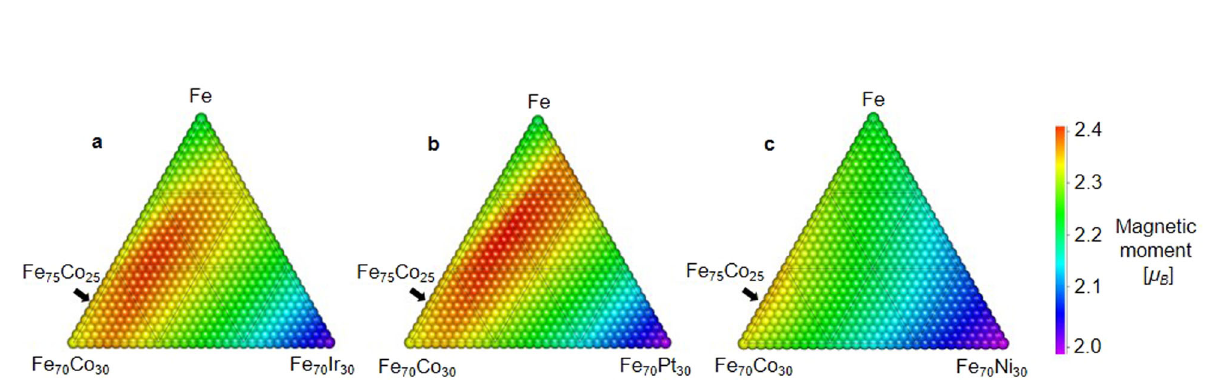
Fig. 3 Experimental con fi rmation by combinatorial XRD, MOKE, and SQUID experiments. a Illustration of combinatorial sputtering system with an automated moving mask for synthesizing Fe x Co y Ir 100-x-y , Fe x Co y Pt 100-x-y , and Fe x Co y Ni 100-x-y composition-spread thin fi lms on SiO 2 /Si substrates. b Composition map of Fe x Co y Ir 100-x-y composition-spread thin fi lm, where the Ir composition gradient is along the X direction, and Fe and Co composition gradients are along opposite Y directions. The black spots denote sampling points of the combi-MOKE experiments. c Results of combi-XRD experiments with Fe x Co y Ir 100-x-y composition-spread sample. d XRD curve of Fe 68.1 Co 26.2 Ir 5.7 (bottom right point in Fig. 3b) e Results of combi-MOKE experiments with Fe x Co y Ir 100-x-y composition-spread sample. f MOKE curves of Fe 68.1 Co 26.2 Ir 5.7 (bottom right point in Fig. 3b). g – i Composition maps of Fe x Co y Ir 100-x-y , Fe x Co y Pt 100-x-y , and Fe x Co y Ni 100-x-y composition-spread thin fi lms, respectively. j – l Mapping of amplitude of MOKE curves M MOKE ( ∝ saturation magnetization M s ) of the Fe x Co y Ir 100-x-y , Fe x Co y Pt 100-x-y , and Fe x Co y Ni 100-x-y composition-spread thin fi lms, respectively. Small amounts of Ir and Pt impurities enhance the M MOKE , while Ni impurity monotonically decreases the M MOKE . m M MOKE plots of (Fe 75.2 Co 24.8 ) 1-x Ir x , (Fe 75.3 Co 24.7 ) 1-x Pt x , and (Fe 71.1 Co 28.9 ) 1-x Ni x along dotted arrows in Fig. 3h – j, respectively. The dark-blue solid line and blue dotted line show theoretical M MOKE values of pure Fe and Fe 75 Co 25 , respectively. n , o Magnetization curves obtained in SQUID experiments with Fe 73.2 Co 24.2 Ir 2.6 , Fe 84.0 Co 12.0 Pt 4.0 , Fe 75.2 Co 24.8 , and pure Fe at room temperature ( T = 300 K) and low temperature ( T = 5 K). The magnetization enhancement due to Ir and Pt impurities were also observed in the SQUID experiments.